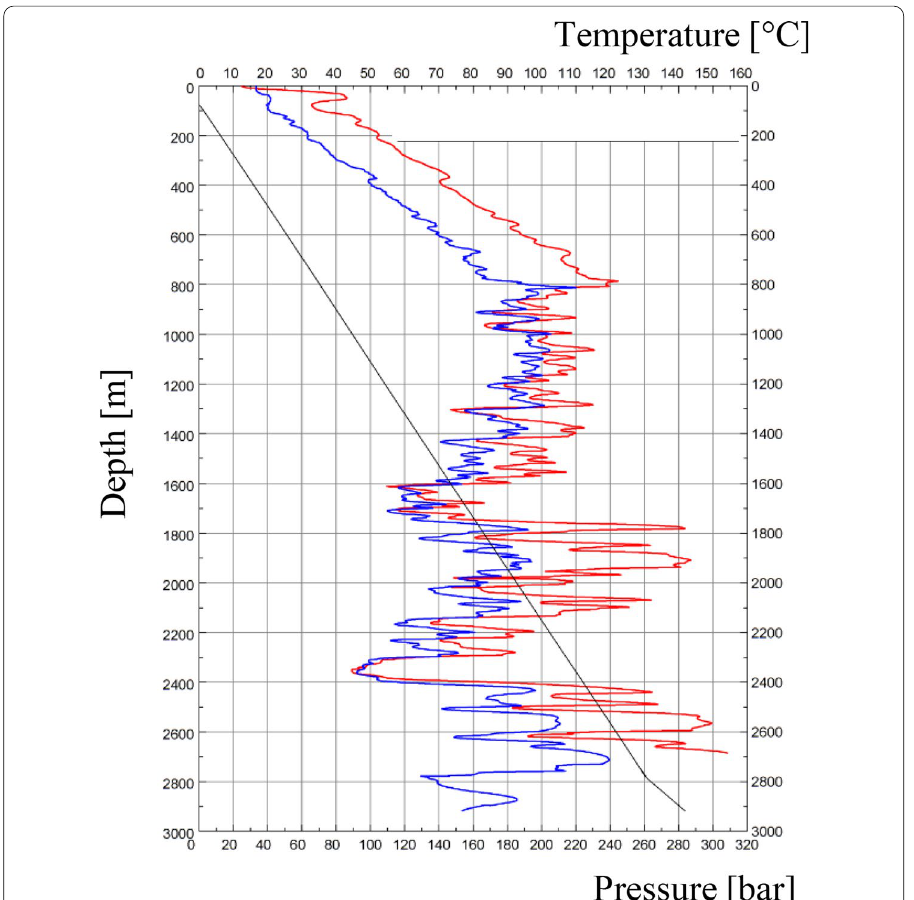
Fig. 2 Temperature (blue line) and pressure (black line) logged on September 6th at 15:00, Q Temperature (red line) logged on September 7th at 14:04 after completion of cementing job. Cement bond logs were carried out subsequently. Depth reference is Thor rig floor (9.0 m above surface). Figure modified from (Stefánsson et al.